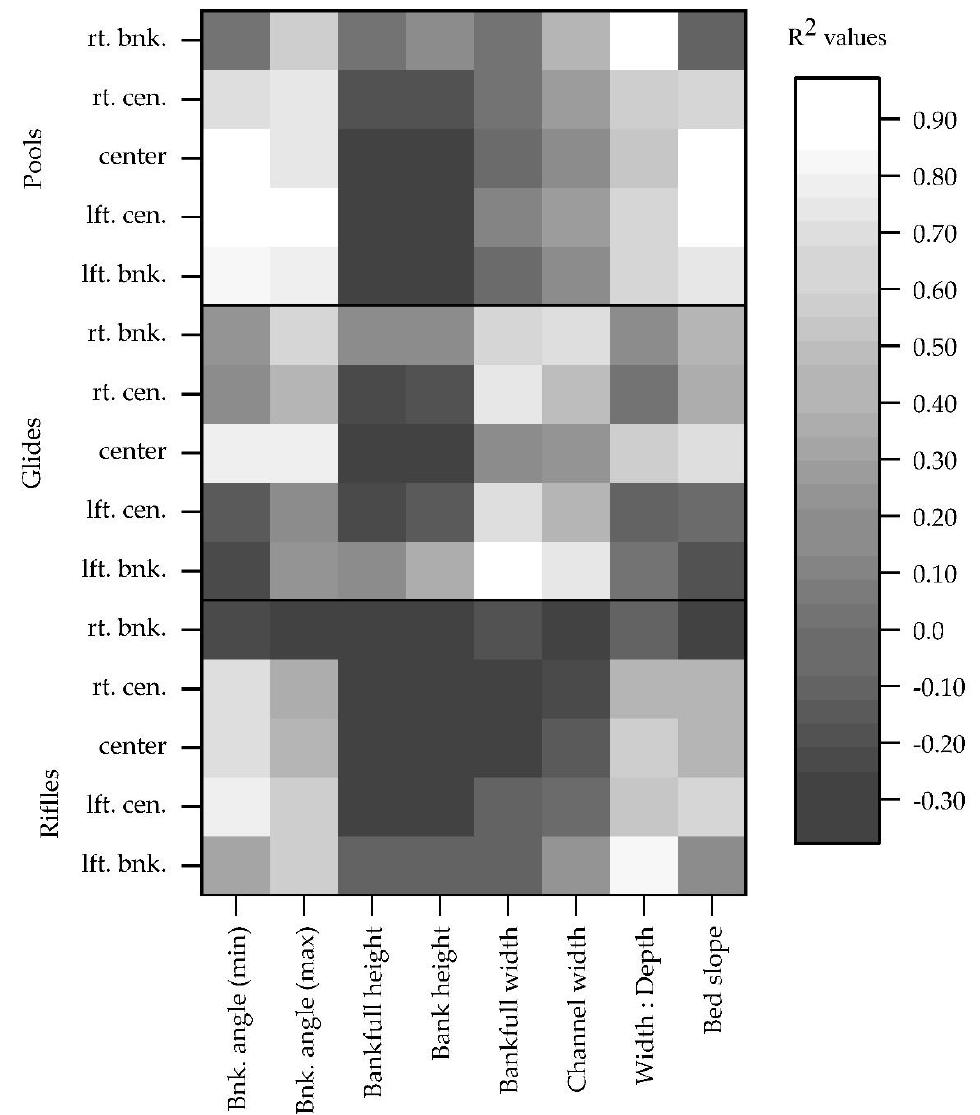
Figure5. Explainedvariancebetweenchannelmorphologymetrics(x-axis)andsubstrateembeddedness Figure 5. Explained variance between channel morphology metrics (x-axis) and substrate from left bank (lft. bnk.) to right bank (rt. bnk.) associated with ri ffl es, glides, and pools (y-axis) at five embeddedness from left bank (lft. bnk.) to right bank (rt. bnk.) associated with riffles, glides, and sub-basins of Hinkson Creek Watershed, Missouri, USA. No glide channel units were observed at Site pools (y-axis) at five sub-basins of Hinkson Creek Watershed, Missouri, USA. No glide channel units #1, instead, percent embeddedness of dry channel units is were observed at Site #1, instead, percent embeddedness of dry channel units is shown.